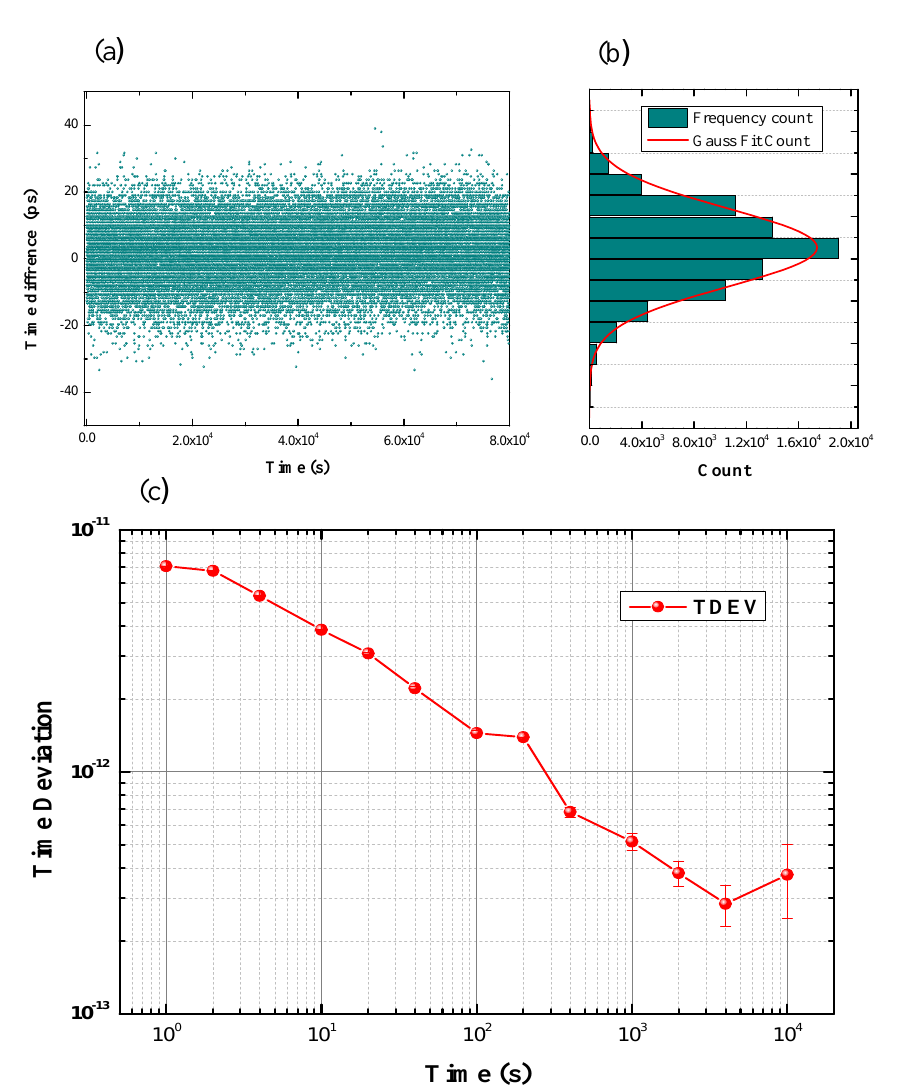
Figure 4. ( a ) The time interval variation of the 1 PPS time signal; ( b ) the statistic results of the 1 PPS time data; ( c ) the TDEV of the 1 PPS time